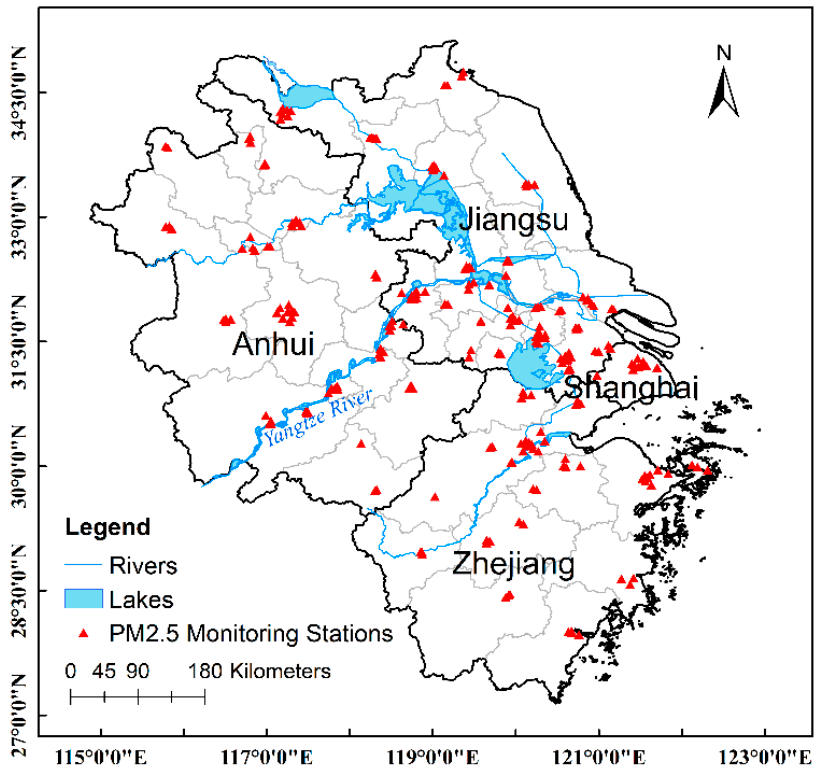
Figure 1. Study area and PM 2.5 monitoring station locations.